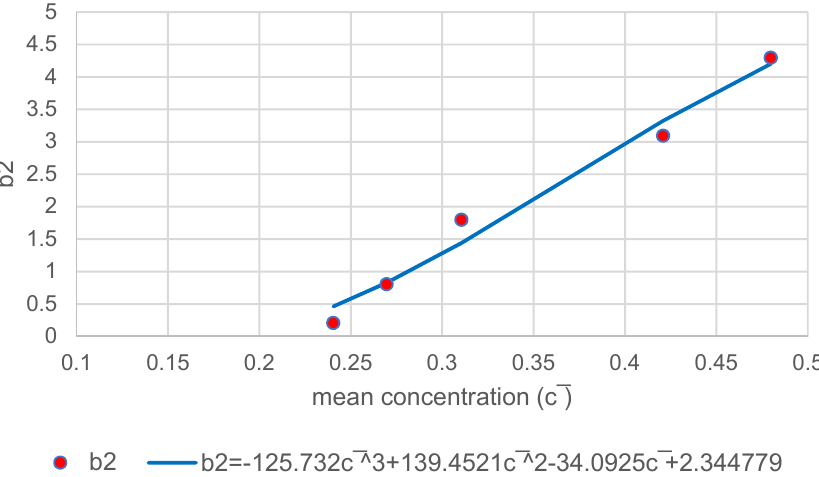
Figure 14. Mean concentration vs. coefficient d 1 using decision trees ( R 2 = 0.9617).